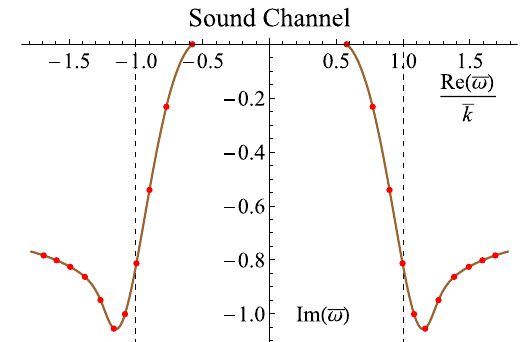
Fig. 10 The location of the two sound poles in the lower complex plane. The red dots are at values of ¯ k = 0 , 1 , 2 ,... . For large wave- lengths, the location and residue are described by hydrodynamic gradi- ent expansion. For large ¯ k the poles move to large real